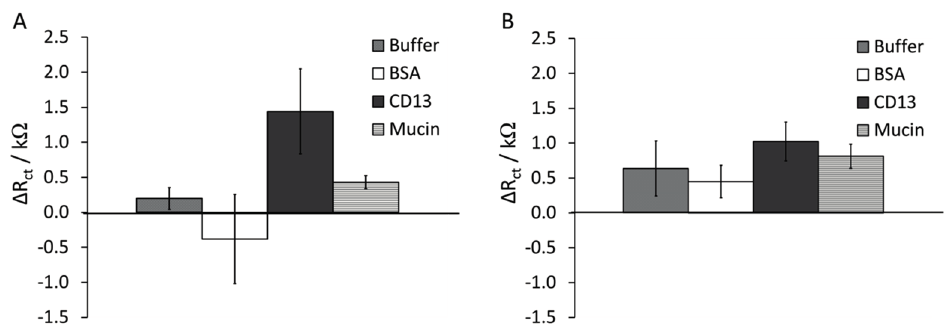
Figure 5. Plot of change in R ct as a function of protein solution during adsorption onto YNGRT-Au ( A ) and VLGXE-Au ( B ) surfaces (each protein was at 10 µg·mL − 1 whereas buffer refers to the protein-free